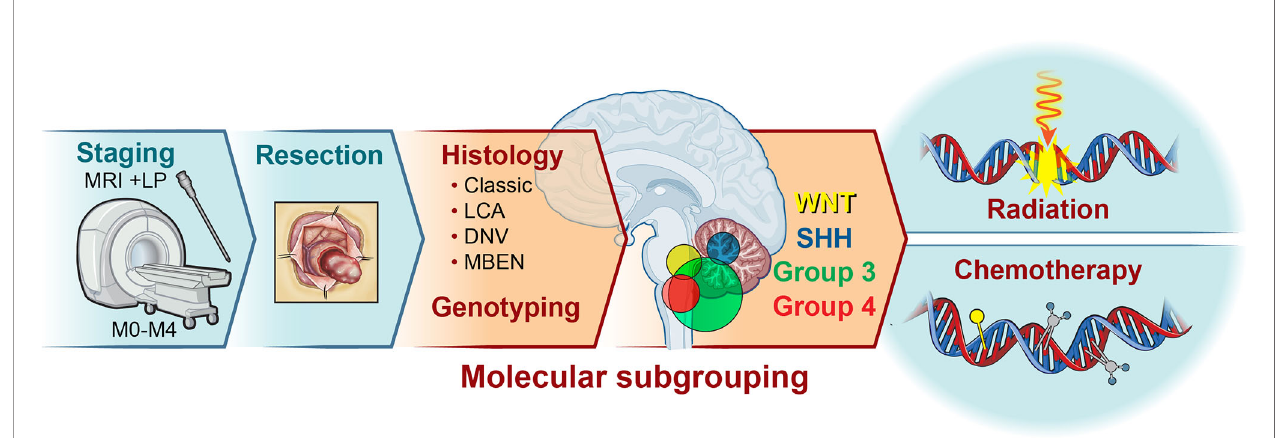
FIGURE 1 | Medulloblastoma is a tumor of the cerebellum. Medulloblastoma constitutes the most common childhood malignant brain tumor, accounting for approximately 20% of all central nervous system tumors. Patient strati fi cation consists of categorization based on age and presence of metastasis, histology, and genotyping. Following initial staging*, maximal surgical resection is typically attempted for all patients. Subsequent histology and molecular pro fi ling introduces subgroup classi fi cation and potential alterations to the treatment protocol. While the vast majority of patients receive some combination of radiation and chemotherapy, the age, location of tumor (2), extent of spread, histology, and subgroup inform the intensity and duration of treatment. MRI, Magnetic Resonance Imaging; STR, Subtotal Resection; GTR, Gross Total Resection; LCA, Large Cell Anaplastic; DNV, Desmoplastic/Nodular; MBEN, medulloblastoma with extensive nodularity; LP, Lumbar Puncture *may be delayed to